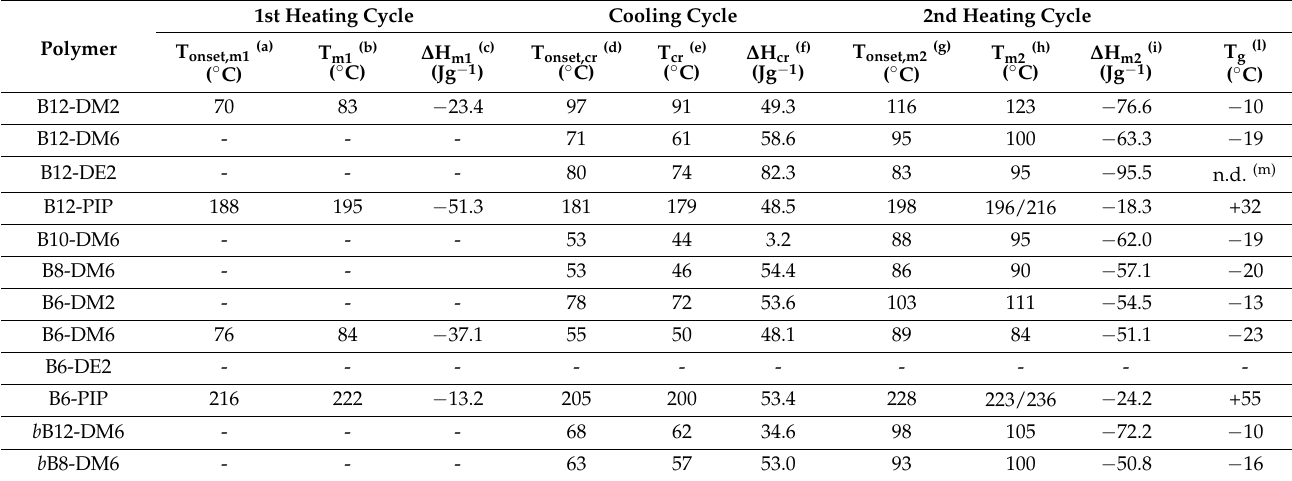
Table 6. Thermal data collected by